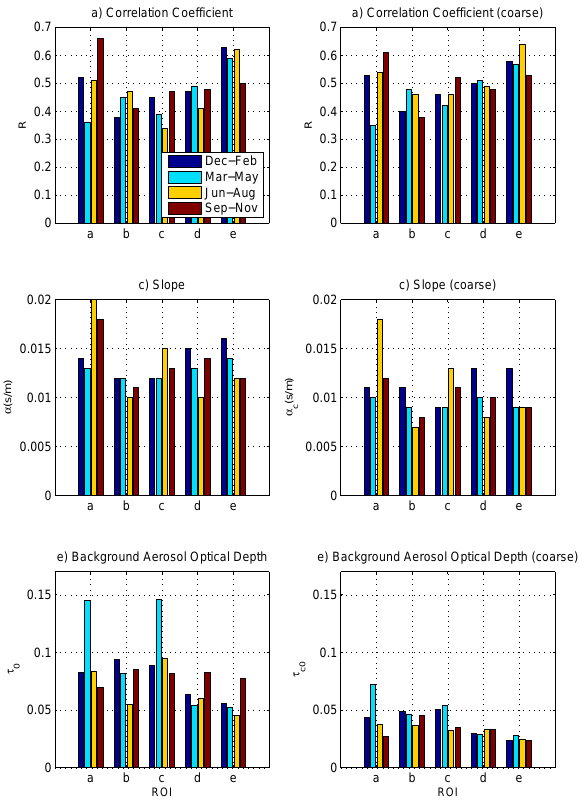
Fig. 5. Seasonal averages of (a) R ; (b) R c ; (c) α ; (d) α c ; (e) τ 0 ; (f) τ c 0 . The bars are sorted according to the regions of interest (regions a–e in Fig. 1).